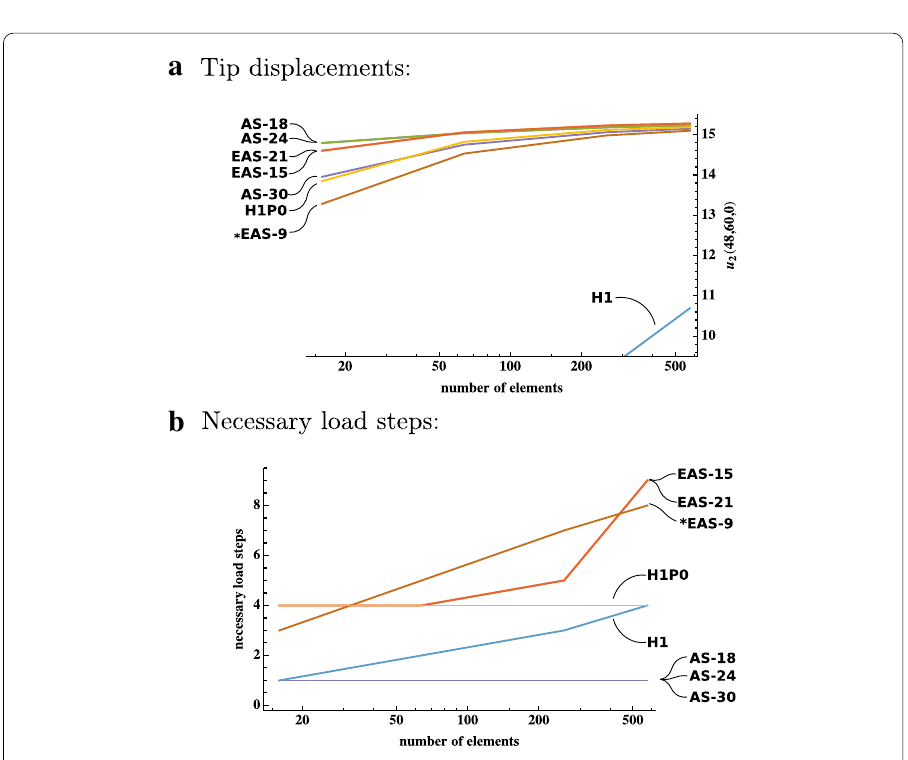
Fig. 8 Cook’s membrane problem: convergence of tip displacement ( a ) and number of necessary load steps ( b ) over the number of